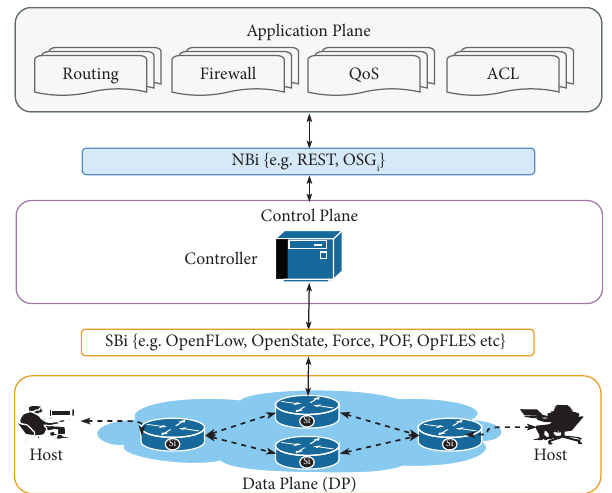
Figure 2: the application plane (AP), the control plane (CP), and the data plane (DP). Te communication between AP and CP is managed through the northbound (NB) interface.